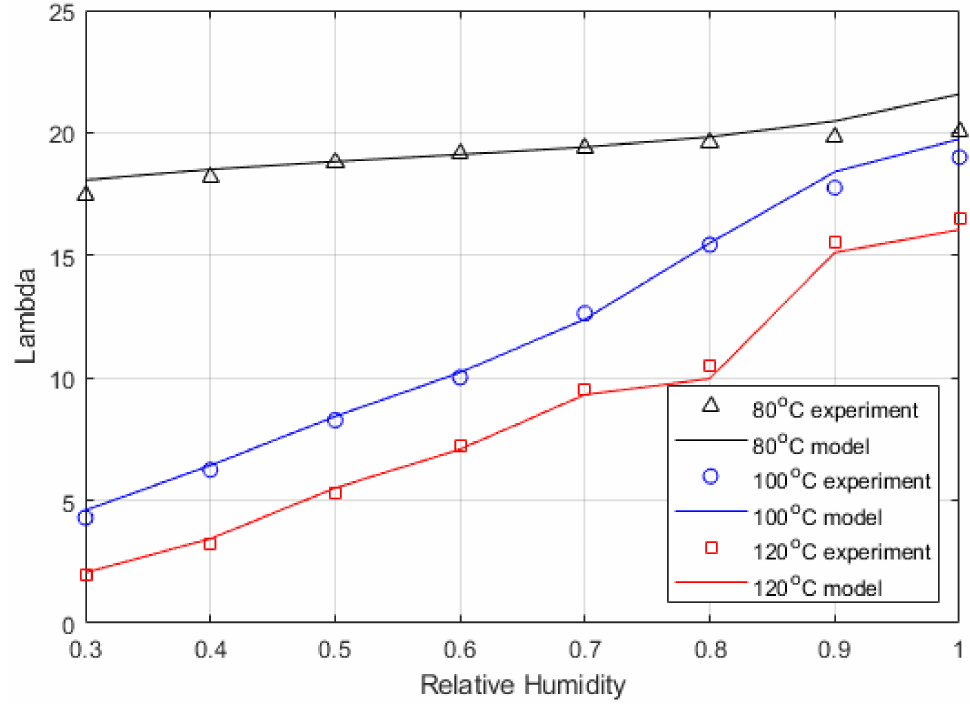
Figure 6. Measured (from HFR impedance spectroscopy) and predicted water content from the developed model versus relative